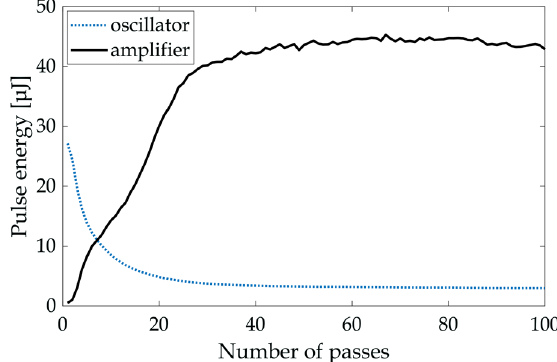
FIG. 15. Overview of the photon pulse energy per pass in the resonator (at the end of the modulator) and in the amplifier (at optimized final length). The output wavelength of the simulations is 4.17 nm, which is the 12th harmonic of 300 nm seed that initiates the process during the first pass only. Here we show the energy for 100 passes.